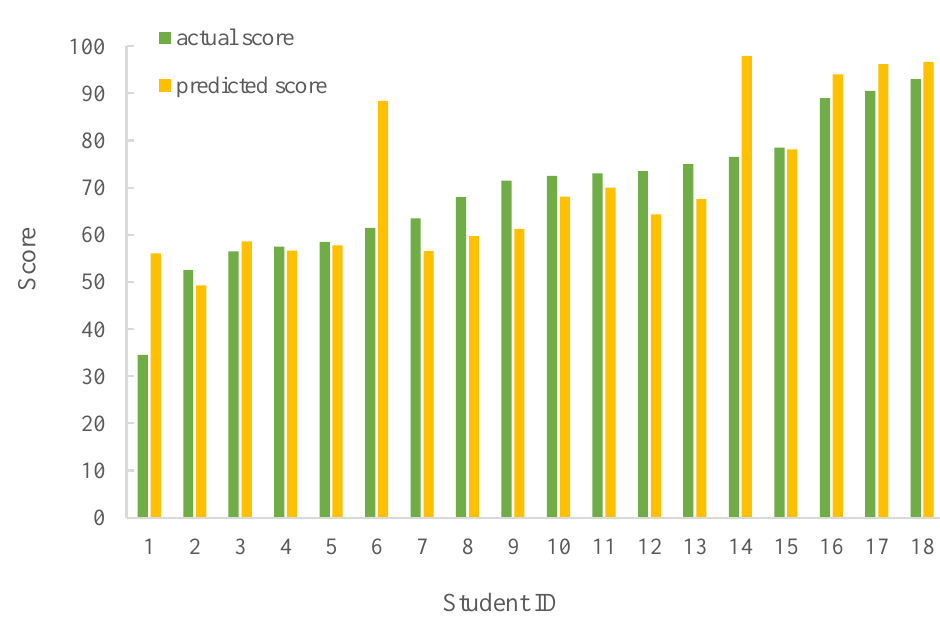
Figure 6. Comparison on predicted score and actual score of LWLR.